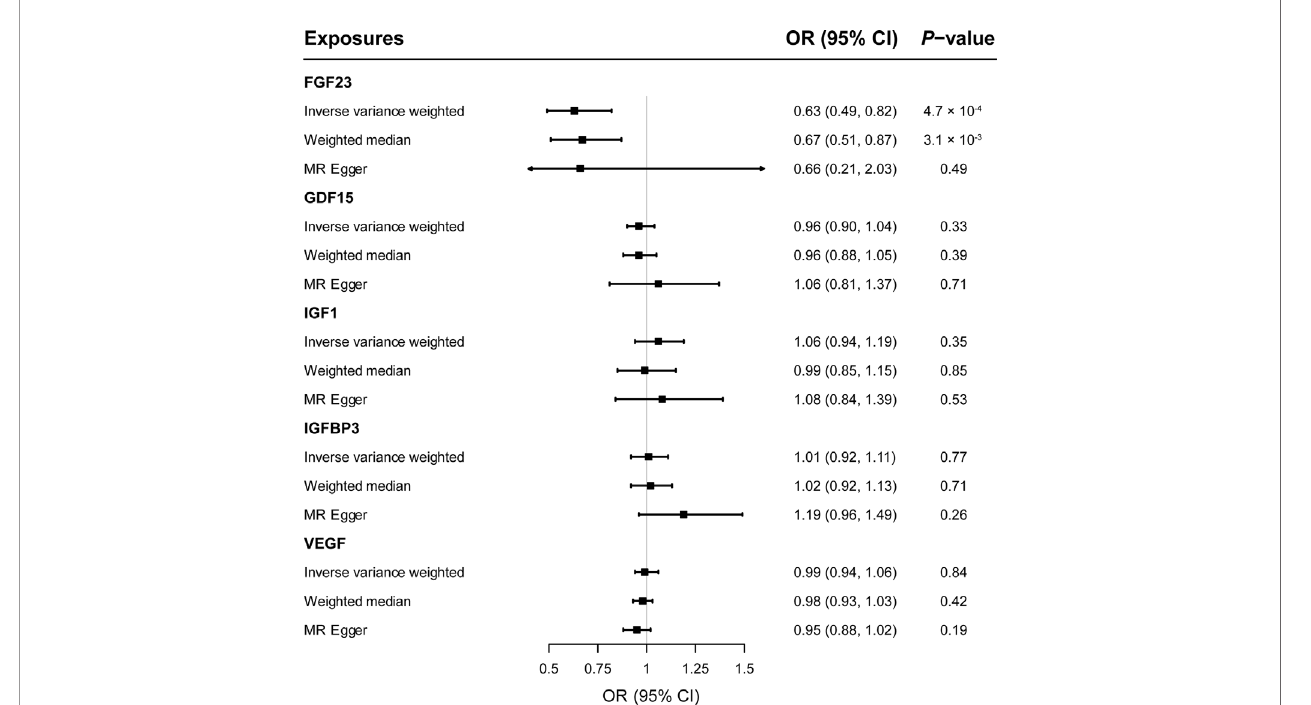
FIGURE 2 | The forest plot delineating causal estimates of growth factors on multiple sclerosis. CI, con fi dence interval; FGF23, fi broblast growth factor 23; GDF15, growth differentiation factor 15; IGF1, insulin-like growth factor 1; IGFBP3, insulin-like growth factor-binding protein 3; VEGF, vascular endothelial growth factor; MS, multiple sclerosis; SNP, Single-nucleotide polymorphism; OR, odds ratio.